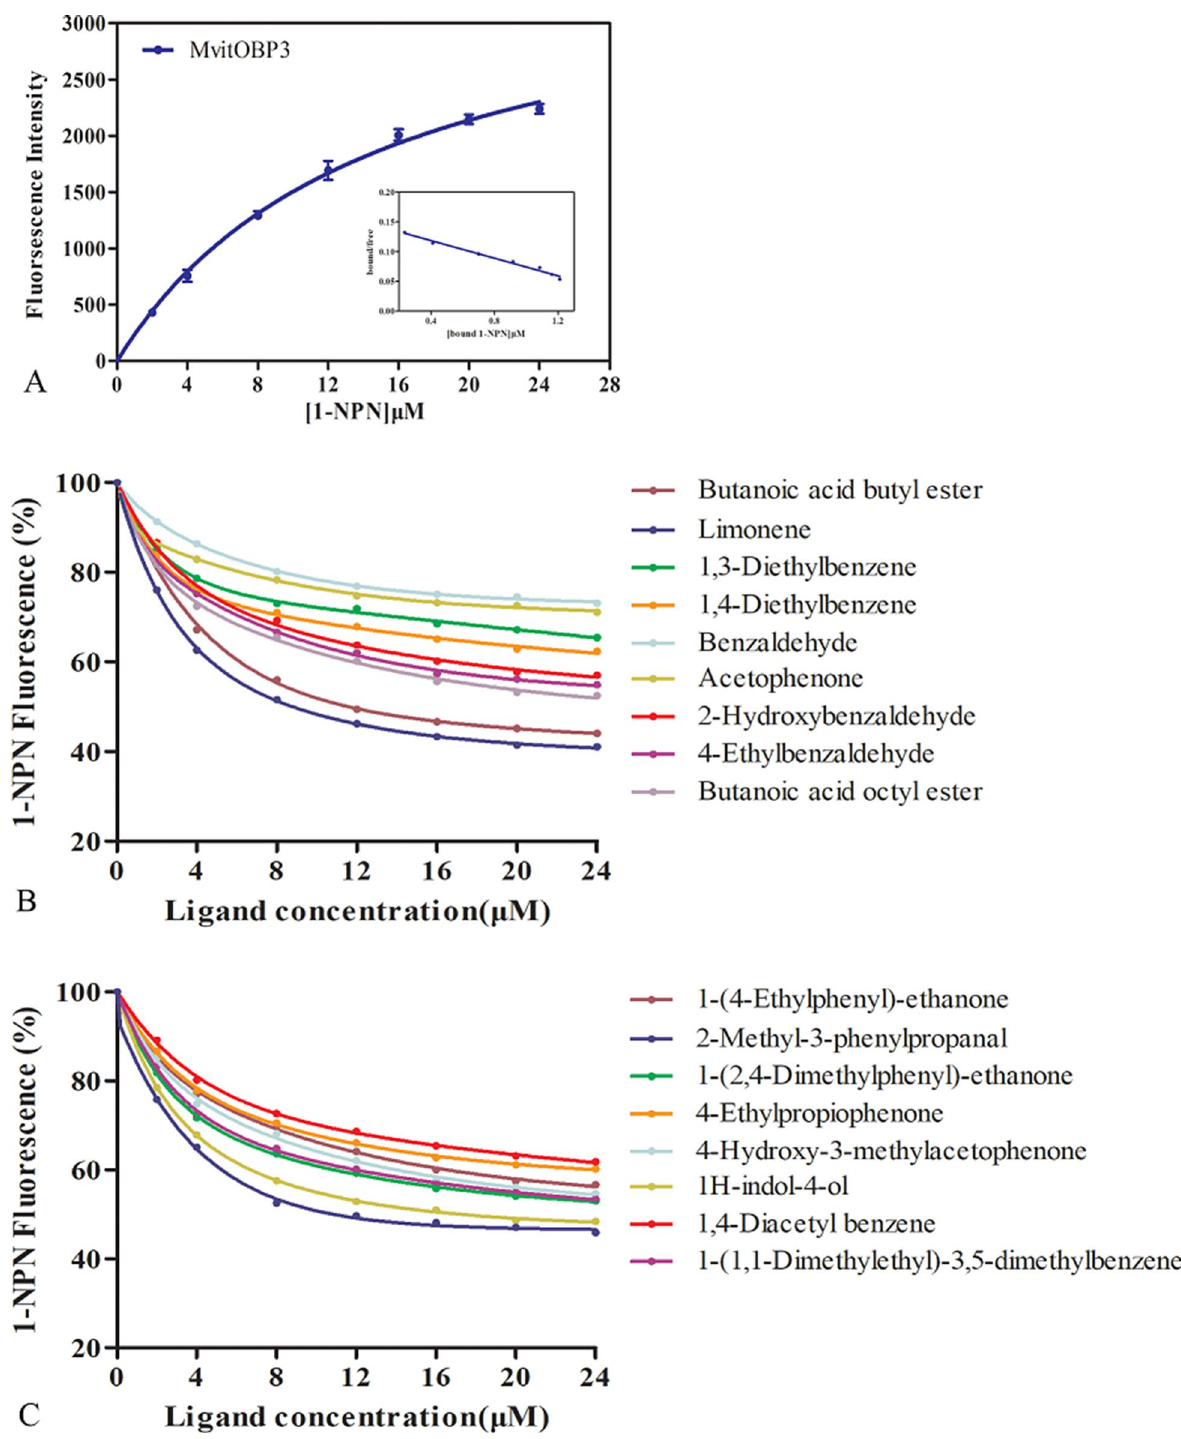
Figure 5. Competitive binding curves of host-plant volatile ligands to MvitOBP3